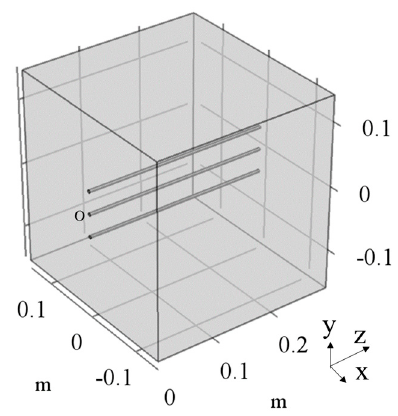
Figure 6. Model N5, established for simulation of the calibration of the vertical probe.